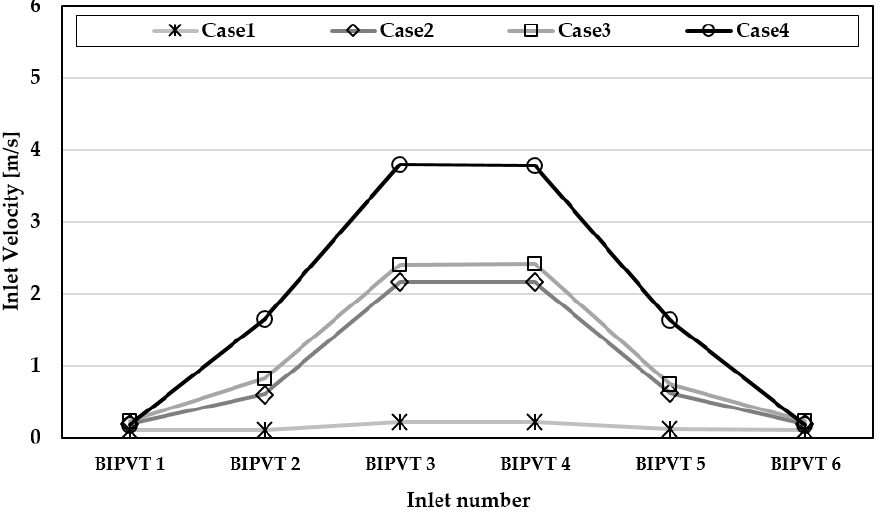
Figure 10. Inlet velocity according to the inlet opening ratio.